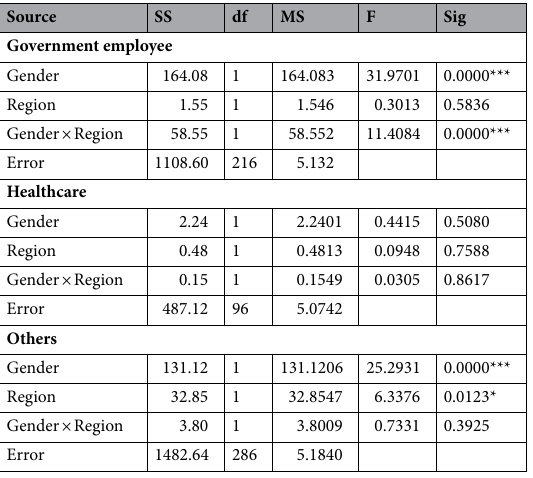
Table 9. Simple interaction effect of different occupations and personal protective measures. * p < .05, *** p < .001.